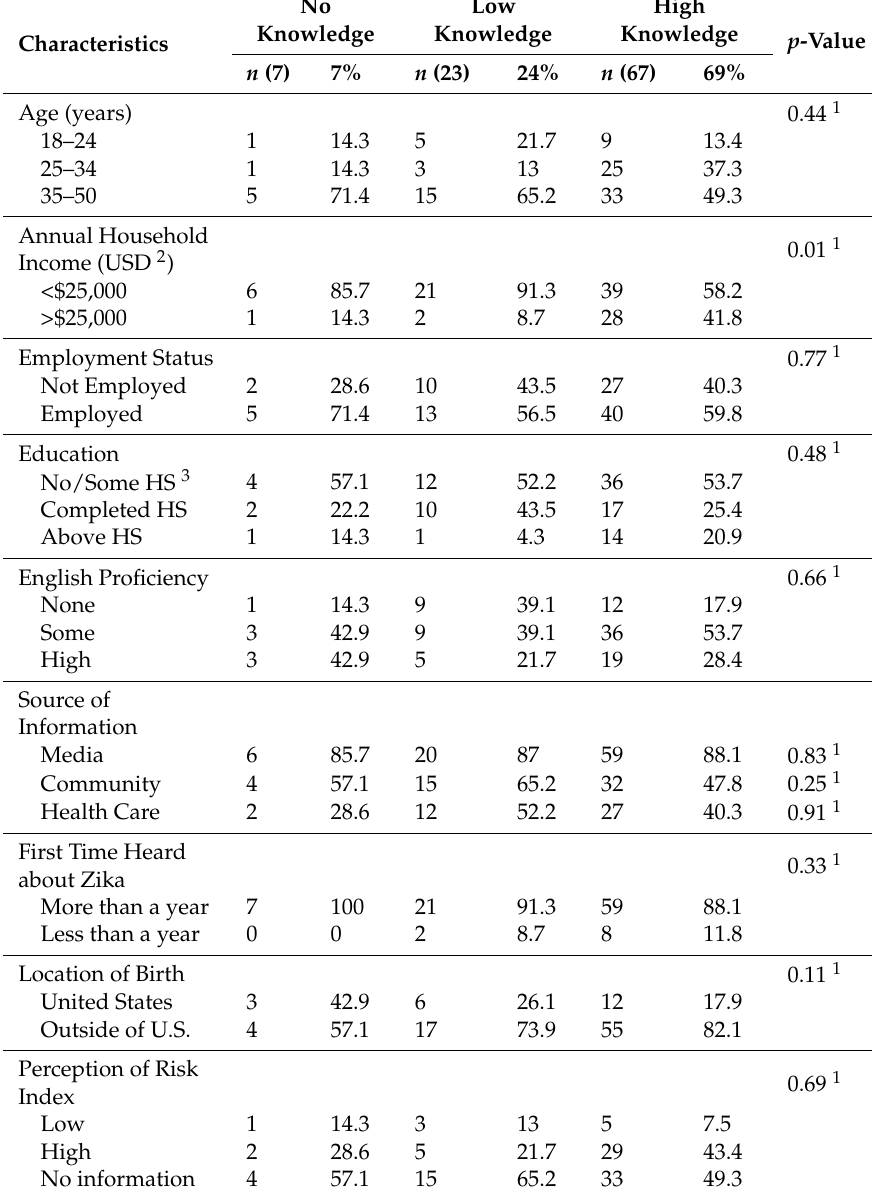
Table 1. Sociodemographic characteristics by degree of knowledge about Zika transmission among Latinas of childbearing age in South Florida ( n =